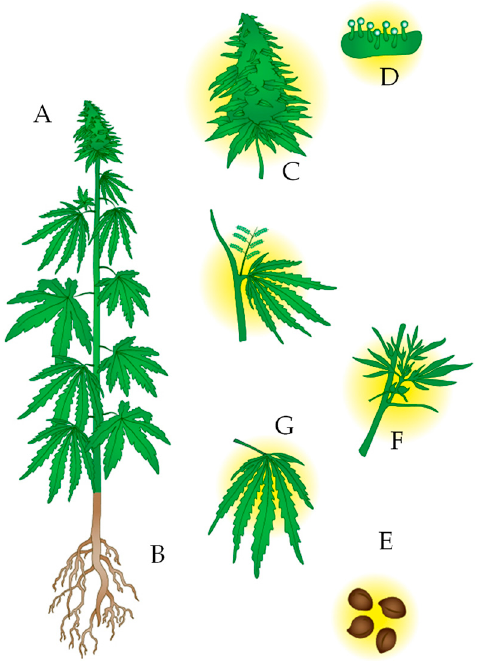
Figure 1. Representation of a Cannabis sativa plant. ( A ). The plant is usually tall and not highly branched, with long and narrow leaves. Depending on whether it is the drug type or fiber type, the stem can be thin or thick, respectively. ( B ). It has fasciculate roots. ( C ). The flower, in the case of female plants, develops in the upper part of the plant. Male plants do not have a flower. ( D ). Glandular trichomes store secondary metabolites, both cannabinoids and terpenes or phenolic compounds. ( E ). From the seeds, the oil can be extracted, and there are high contents of THC and CBD in their bark since they are in contact with the leaves of the plant. ( F ). Stem. ( G ). Leaves.